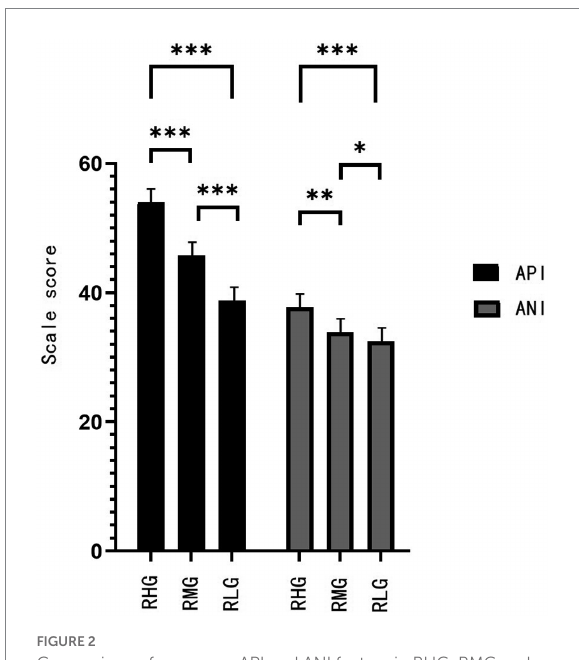
FIGURE 2 Comparison of scores on API and ANI factors in RHG, RMG and RLG. Data are expressed as means ± standard error of the mean (SEM). * p < 0.05, ** p < 0.01 ， *** p < 0.001.